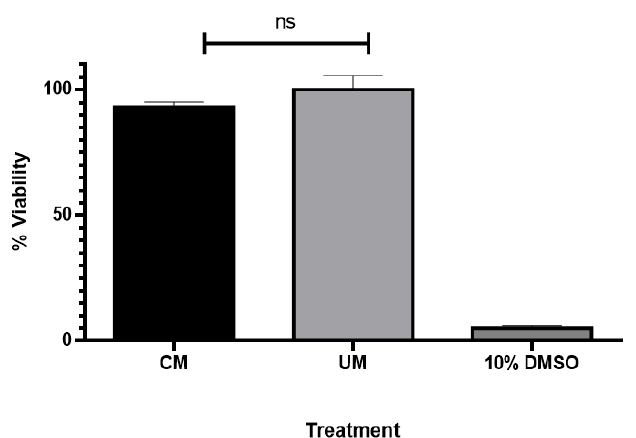
Figure 18. Cytotoxicity effect of circulating medium (CM) from the fluidic system on HUVEC cells.